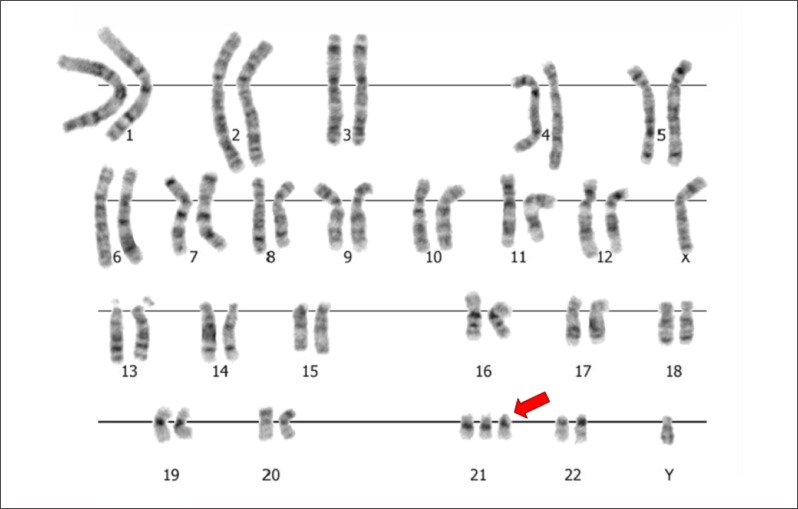
Cariótipo por bandas GTG (banda G por tripsina e Giemsa) evidenciando
trissomia livre do cromossomo 21, compatível com síndrome de Down. Essa é a
principal anormalidade cromossômica observada entre pacientes com
cardiopatia congênita